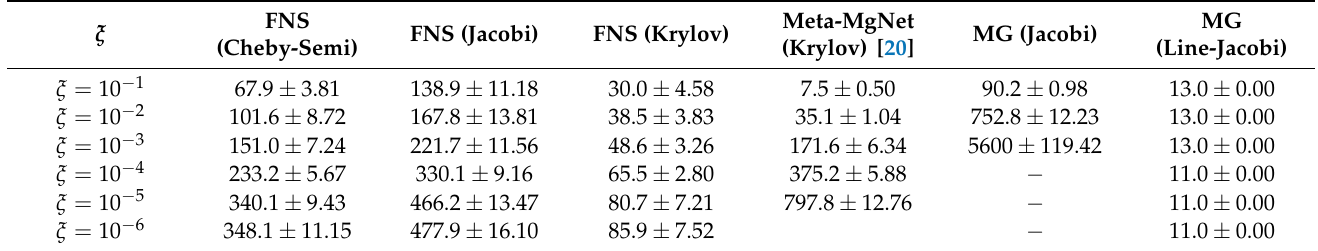
Table 1. Mean and standard deviation of the number of iterations required to achieve the stopping criterion over all tests for the anisotropic diffusion equation case 1. “ − ” means that it cannot converge within 10,000 steps, and “ ” means that [20] does not provide test results for this